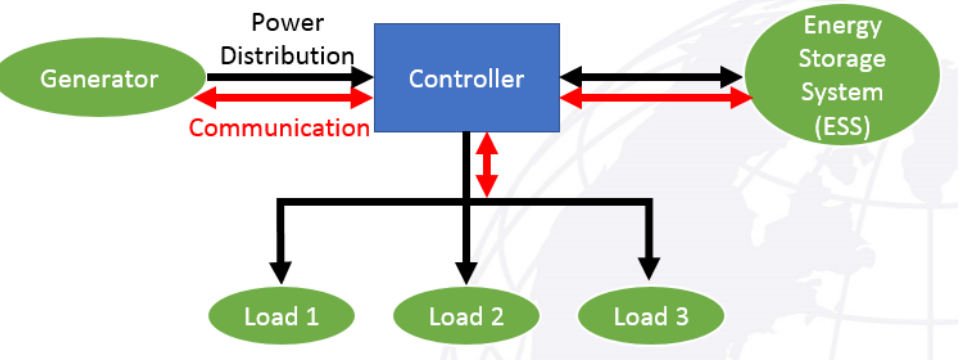
Figure 1. Notional microgrid controller flowchart with power distribution and communication flow. Adapted from Craparo and Sprague